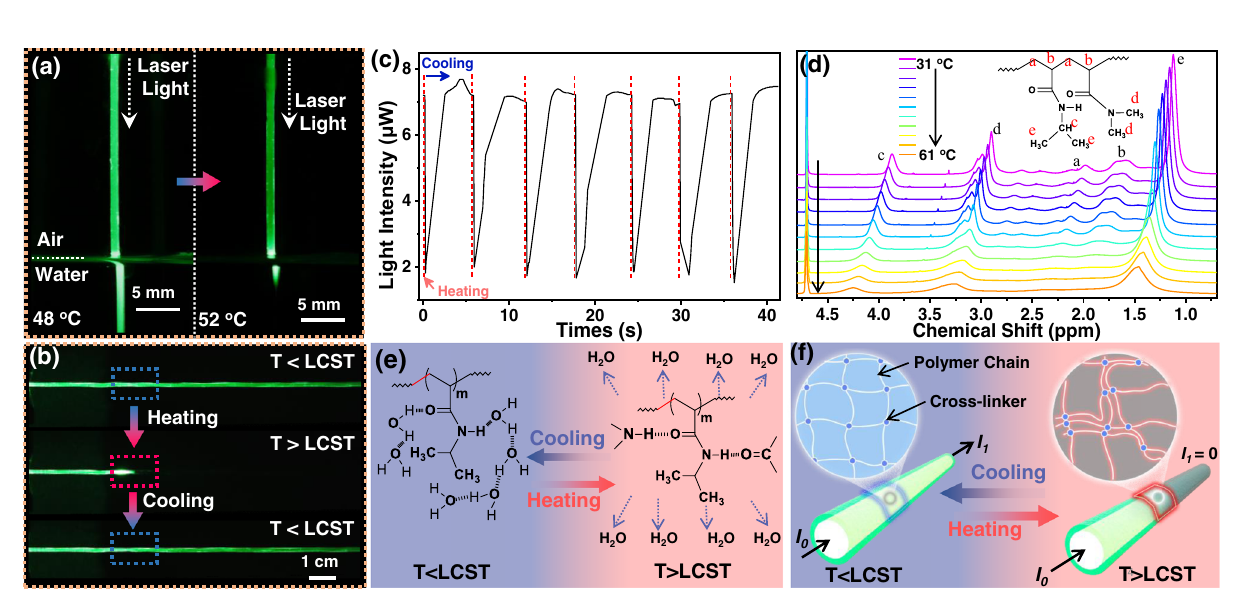
Fig. 4 | Thermo-sensitivityofthe THFOW.a Photos of light propagation through THFOW in water under different temperatures (48°C and 52°C); ( b ) Photos of the light propagate through the THFOW with a segment of THFOW heating up and getting cool in sequence; ( c ) Light intensityvariationduring the cyclicheating and